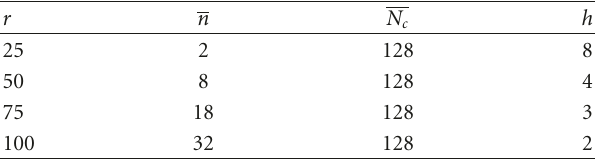
Table 2: Analytical number of hops with various sensor node transmission ranges for a fixed gateway range R =